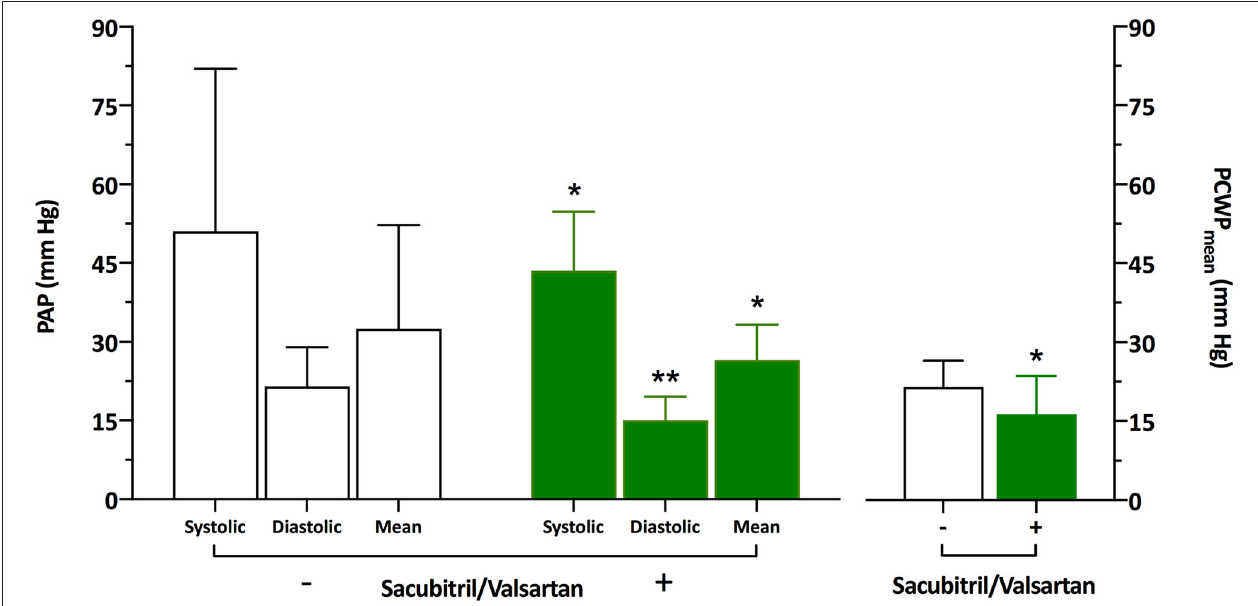
FIGURE 1 | Pulmonary artery pressure (PAP) and mean pulmonary capillary wedge pressure (PCWP) pre (–) and post ( + ) medication with Sacubitril/Valsartan [24/26mg BID (24/26 BID − 49/51 BID)] ( n = 18). Data are given as median and interquartile range. * p < 0.05, ** p < 0.01.